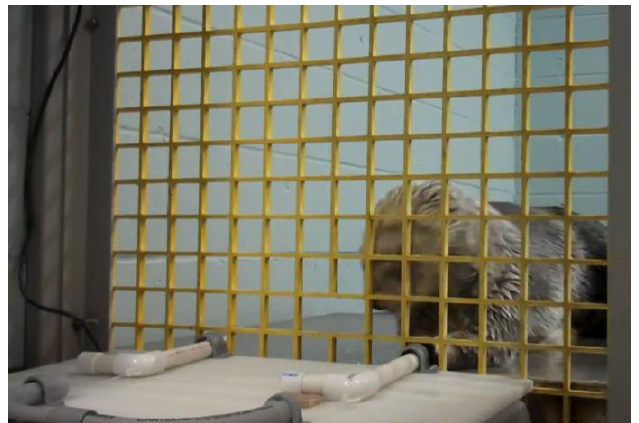
Figure 2. Example of otter interaction with the apparatus during a